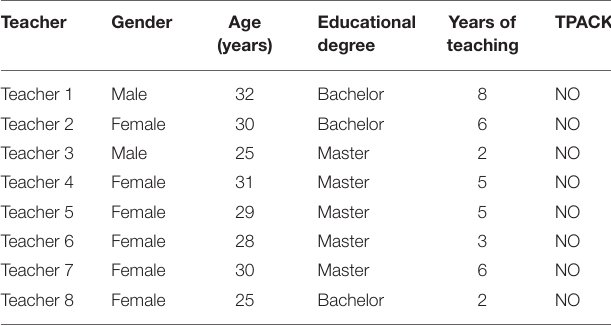
TABLE 1 | Demographic information of